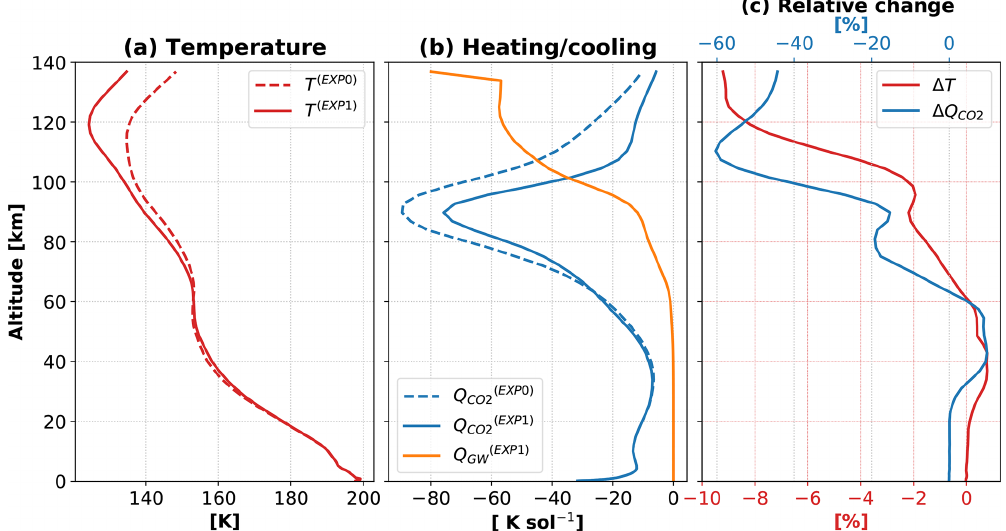
Figure 1. Global annual mean temperature, and cooling by gravity waves and radiative processes in carbon dioxide molecules. (a) Glob- ally averaged annual mean neutral temperature ( T , K) with gravity waves (solid line, “EXP1”) and without gravity waves (dashed lines, “EXP0”); (b) globally averaged annual mean gravity wave heating/cooling Q GW (Ksol − 1 ) (orange line) and CO 2 15µm cooling (blue line); (c) relative percentage change with respect to EXP0 simulations for the temperature (red) and CO 2 cooling (blue), calculated as [ T ( EXP1 ) − T ( EXP0 ) ] /T ( EXP0 ) and [ Q ( EXP1 ) − Q ( EXP0 ) ] /Q ( EXP0 ) . In both panels dashed lines represent the simulation without gravity CO 2 CO 2 CO 2 wave effects, while the solid lines are for the simulation with gravity wave propagation from the lower atmosphere upward. The annual mean refers to an averaging over 1 Martian year (669 sols = 687 Earth days) over all longitudes and